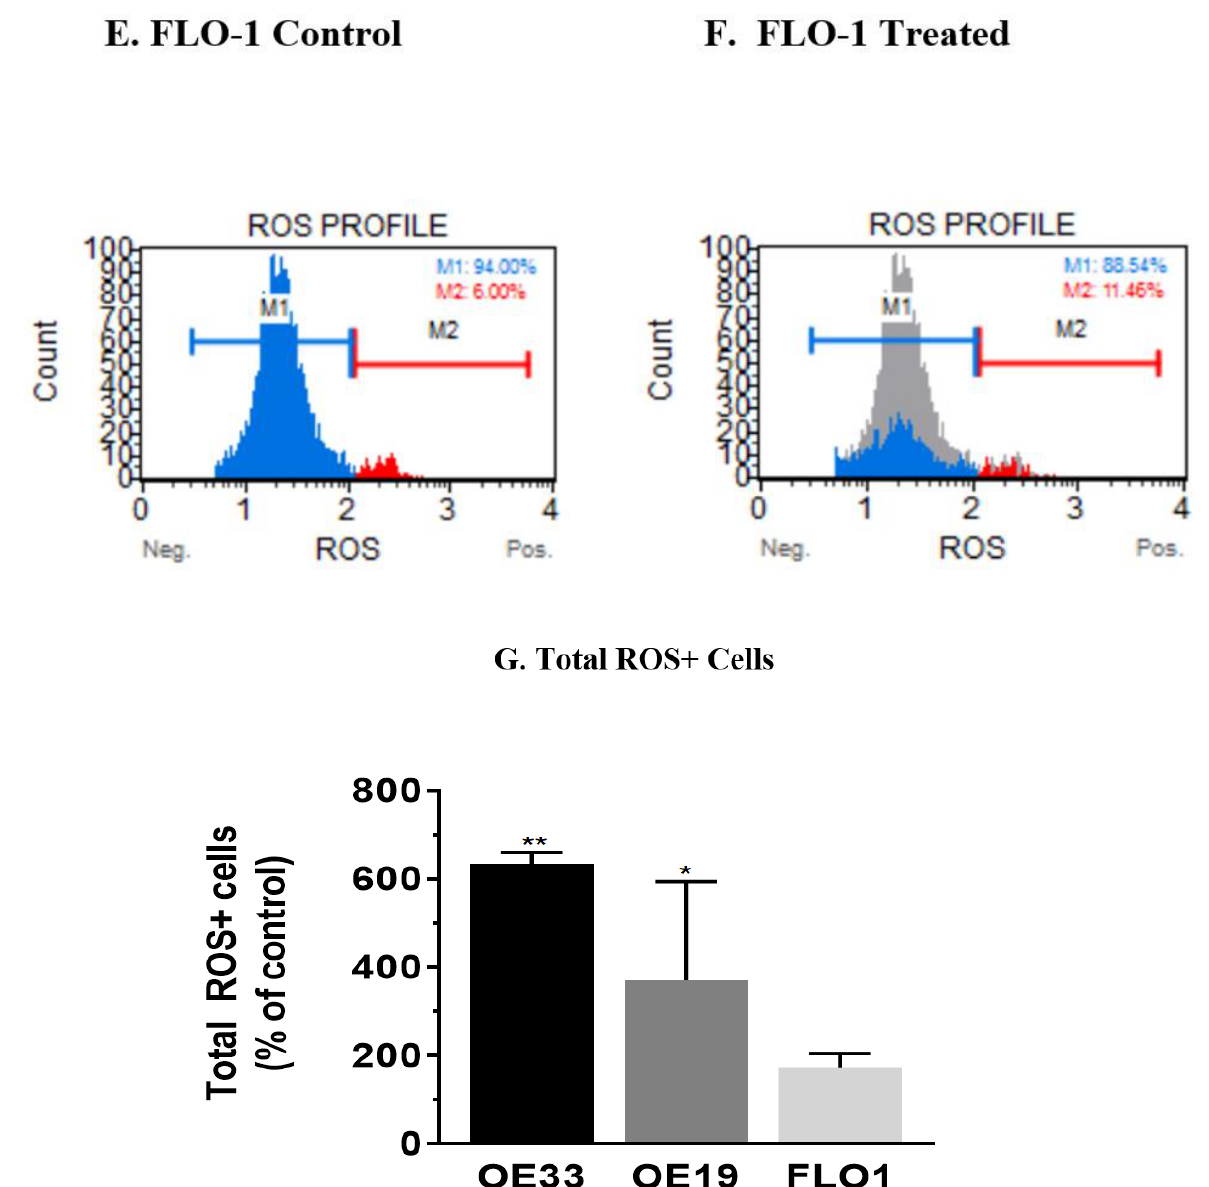
Figure 4. Impact of resveratrol on the levels of reactive oxygen species (ROS) in OE33, OE19 and FLO-1 cells. Cells were seeded at a density of 62,500 cells/well in 12-well plates, treated with resveratrol at 100 µ M for OE33 cells and incubated for 72 h. Three independent experiments were performed. ( A ) Representative Muse Oxidative stress assay plot for the control group. ( B ) Representative plot from Muse Oxidative stress assay for resveratrol-treated OE33 group. Similar experiments were performed to assess the generation of ROS in OE19 cells on treatment with 50 µ M (IC 50 concentration) of resveratrol. ( C ) Representative Muse Oxidative stress assay plot for the control OE19 group. ( D ) Representative plot from Muse Oxidative stress assay for resveratrol-treated OE19 group. For FLO-1 cells, studies performed to assess the generation of ROS were similar to OE33 and OE19 except the concentration of resveratrol was 40 µ M (IC 50 concentration). ( E ) Representative Muse Oxidative stress assay plot for the control FLO-1 group. ( F ) Representative plot from the Muse Oxidative stress assay for resveratrol-treated FLO-1 group. The total ROS-positive cells after normalizing to the control group for each cell line are represented by the bar graph in ( G ). Four independent experiments were performed, and each time, cells were plated and treated in triplicates. * in the bar diagram represents p -values < 0.05 and more asterisks represent p -values of higher significance. M1= Ros ( − ) and M2 = Ros